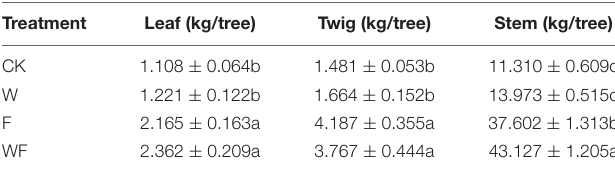
Means ± standard error (SE) were shown (n = 5). The letter after the numbers represented the Duncan’s multiple comparison results. Different lower-case letters indicate differences between various